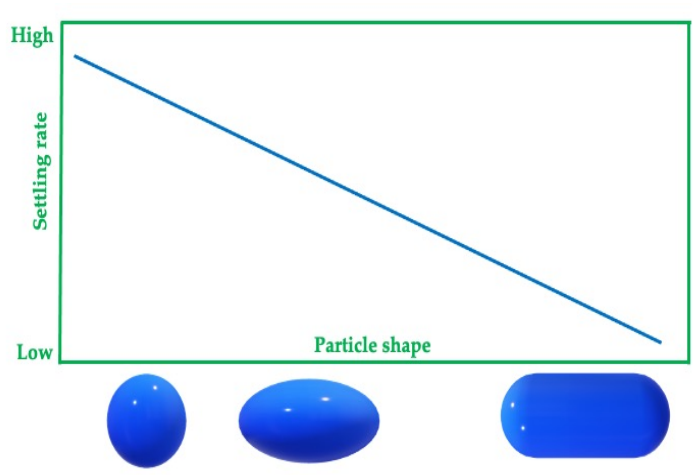
Figure 23. Settling rate versus particle shape (modified from [250,251]) .